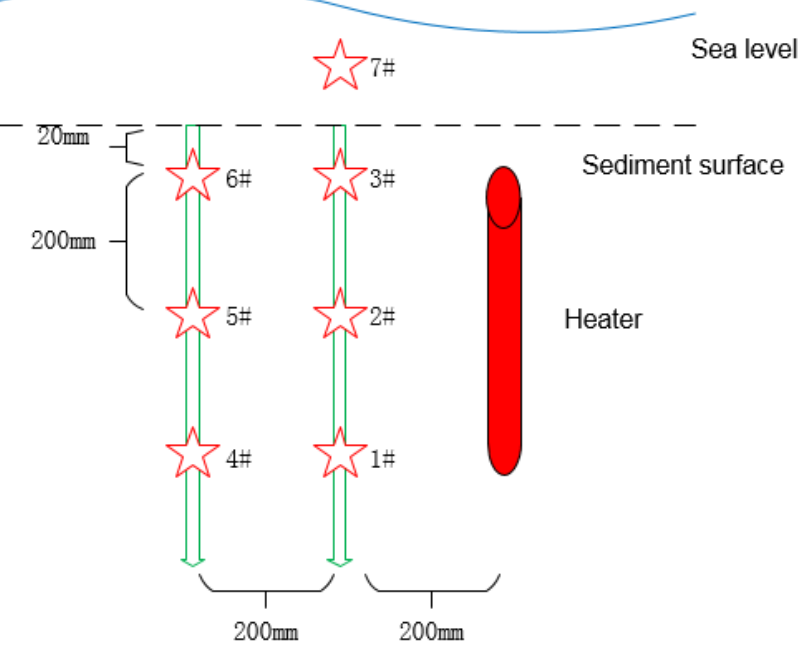
Figure 13. Arrangement of heating source and temperature sensors in the seaside shoal. 1#–7# in the figure represent temperature sensors 1–7.